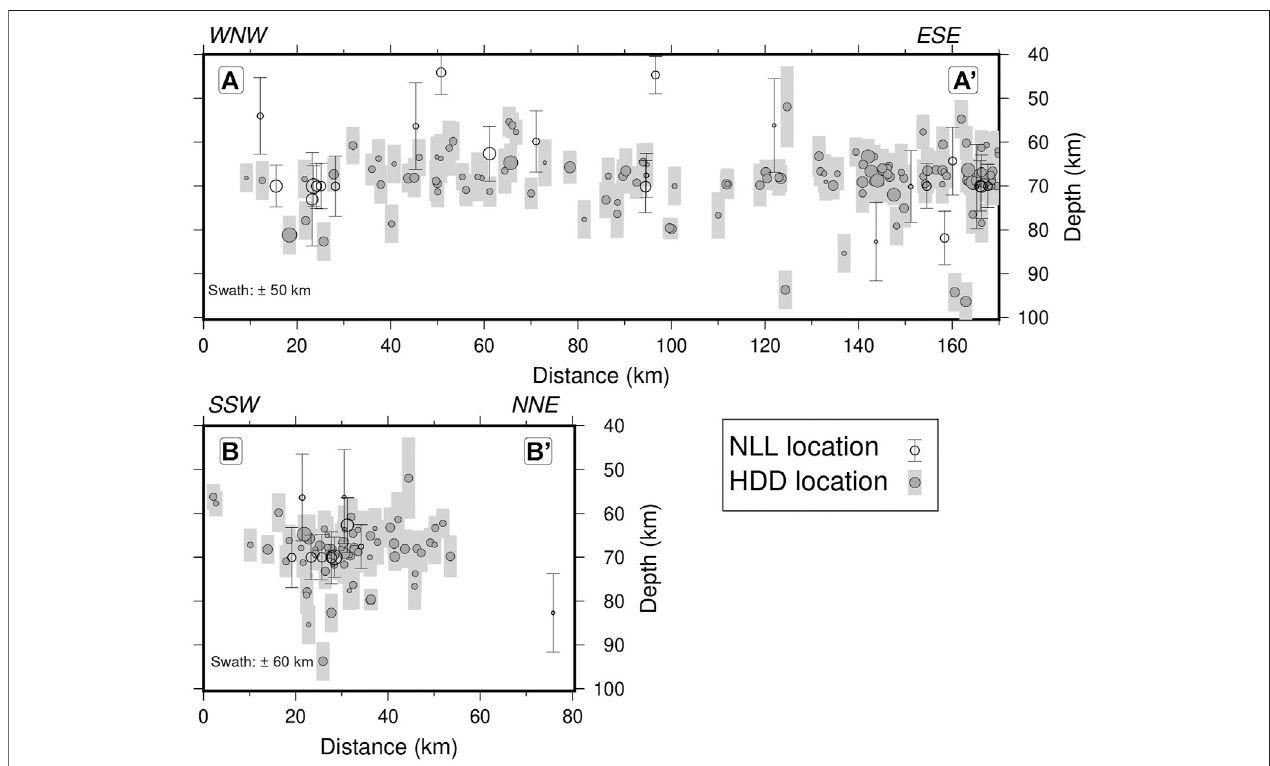
FIGURE 3 | Vertical cross-sections of earthquake hypocenters. Dark gray and black open circles depict the relative and absolute earthquake locations ’ hypocenters. Earthquake location uncertainties are shown as vertical black and light gray bars, respectively. The locations of cross-sections A – A ′ are marked in Figure2 .Earthquakeswithin50and60 kmoneithersideofthecross-sectionsareshown.Notethatcross-sectionsareslightlyverticallyexaggeratedandthesizeofthe symbols are scaled to their respective magnitudes.